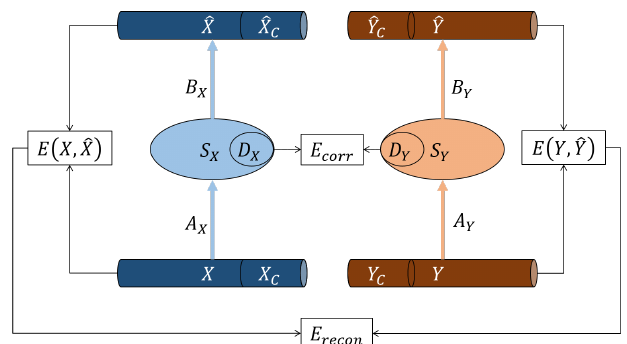
Figure 1. PDAE: The two high-dimensional datasets X and Y include correspondence subsets X C and Y C , resp., and are compressed to low-dimensional manifolds S X and S Y , where D X and D Y are the low-dimensional representations of X C and Y C , respectively. The minimisation of E corr applies regularisation pressure to D X and D Y to align the low-dimensional manifolds S X and S Y